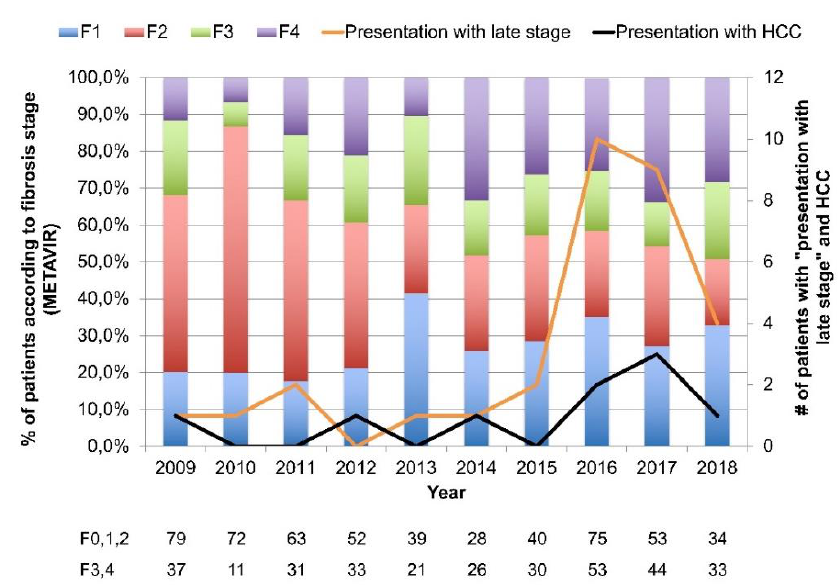
Figure 2. Trends in late presentation to care and presentation with the late stage of liver